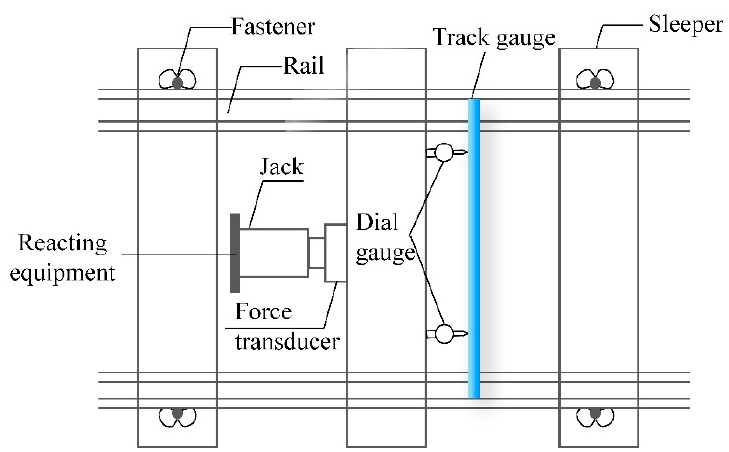
Figure 1. Test schematic diagram of longitudinal ballast resistance.